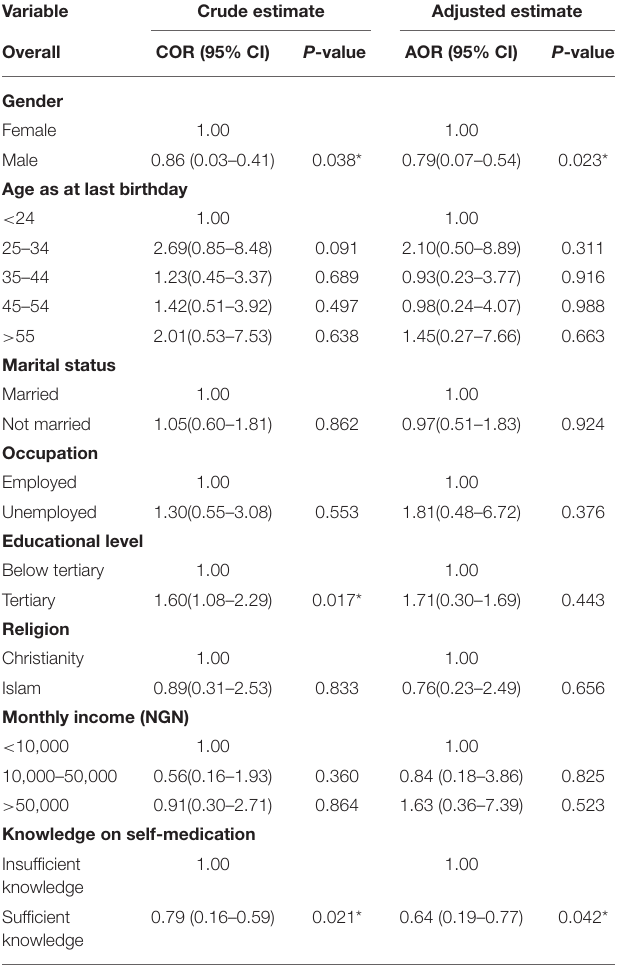
TABLE 3 | Crude and adjusted factors associated with